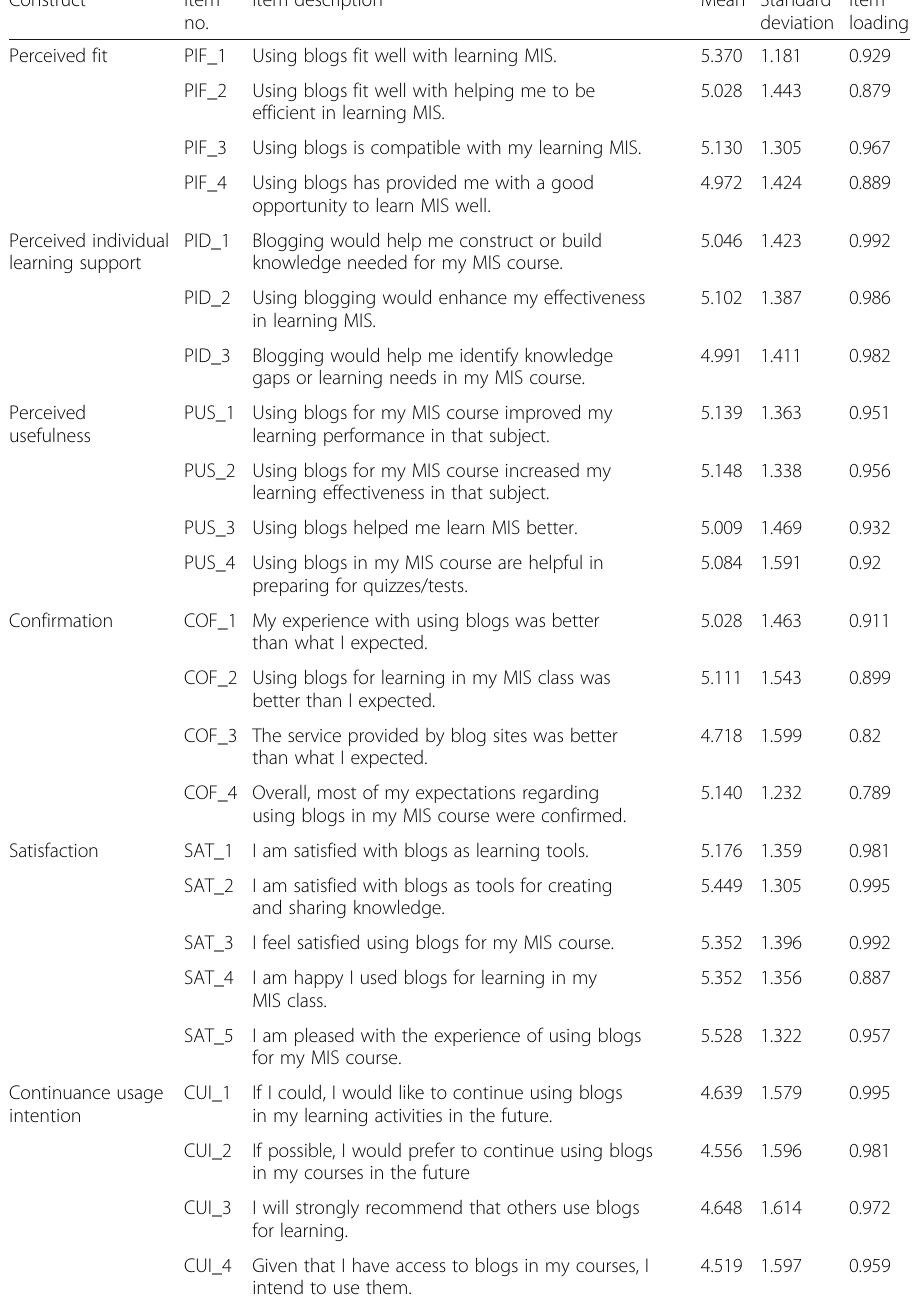
Table 2 The questionnaire ’ s items, their descriptive statistics and item loadings